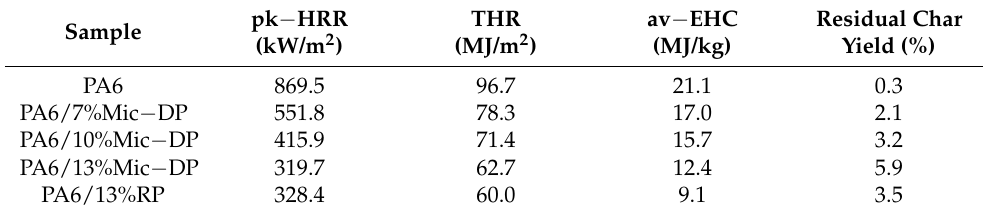
Table 6. Cone calorimeter data of PA6 samples.